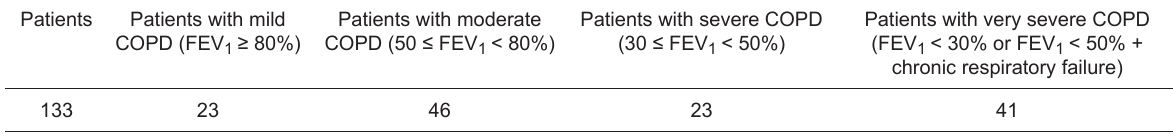
Table 1. Distribution of chronic obstructive pulmonary disease (COPD) patients according to disease severity (1,9).